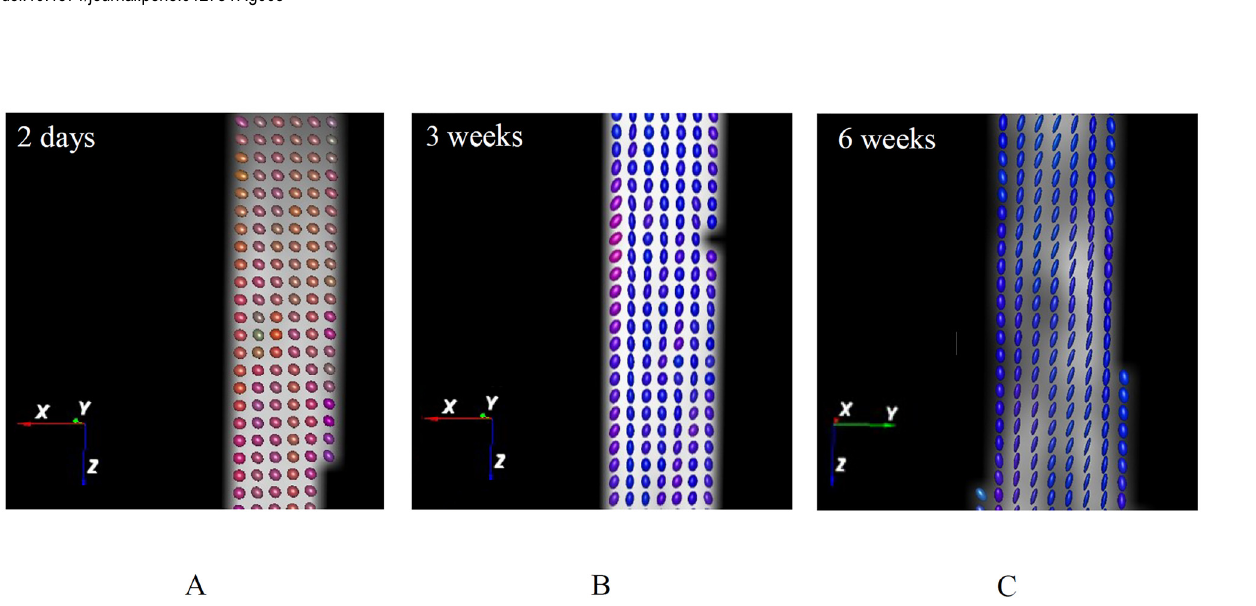
Fig 6. Arrays of ellipsoids obtained from the diffusion tensor of DTI scan in a single slice of middle part (10×3 mm) of TE samples after 2 days (A), 3 weeks (B) and 6 weeks of culture (C). Ellipsoids show the orientation and magnitude of the diffusion in each voxel. Fibers were randomly oriented after 2 days, but they become aligned in the constrained direction after 3 weeks and in the oblique direction in more compacted regions after 6 weeks.